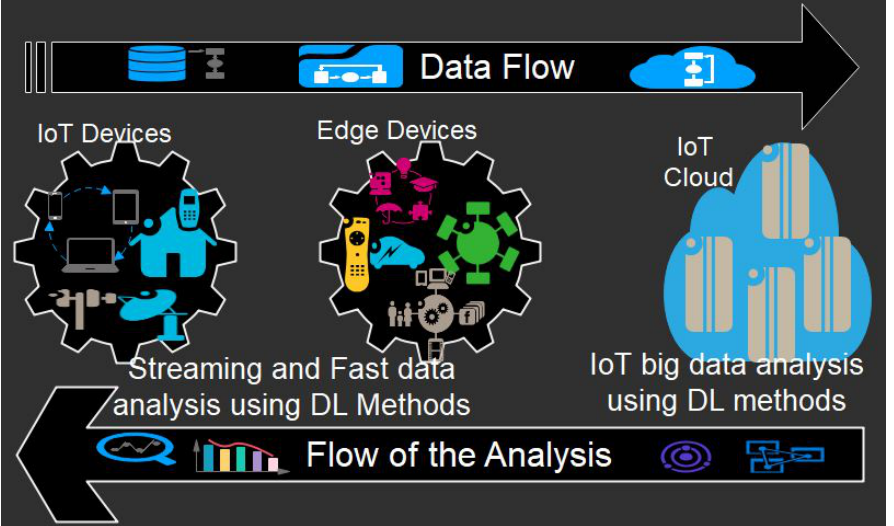
Figure 1. Data generation and processing of